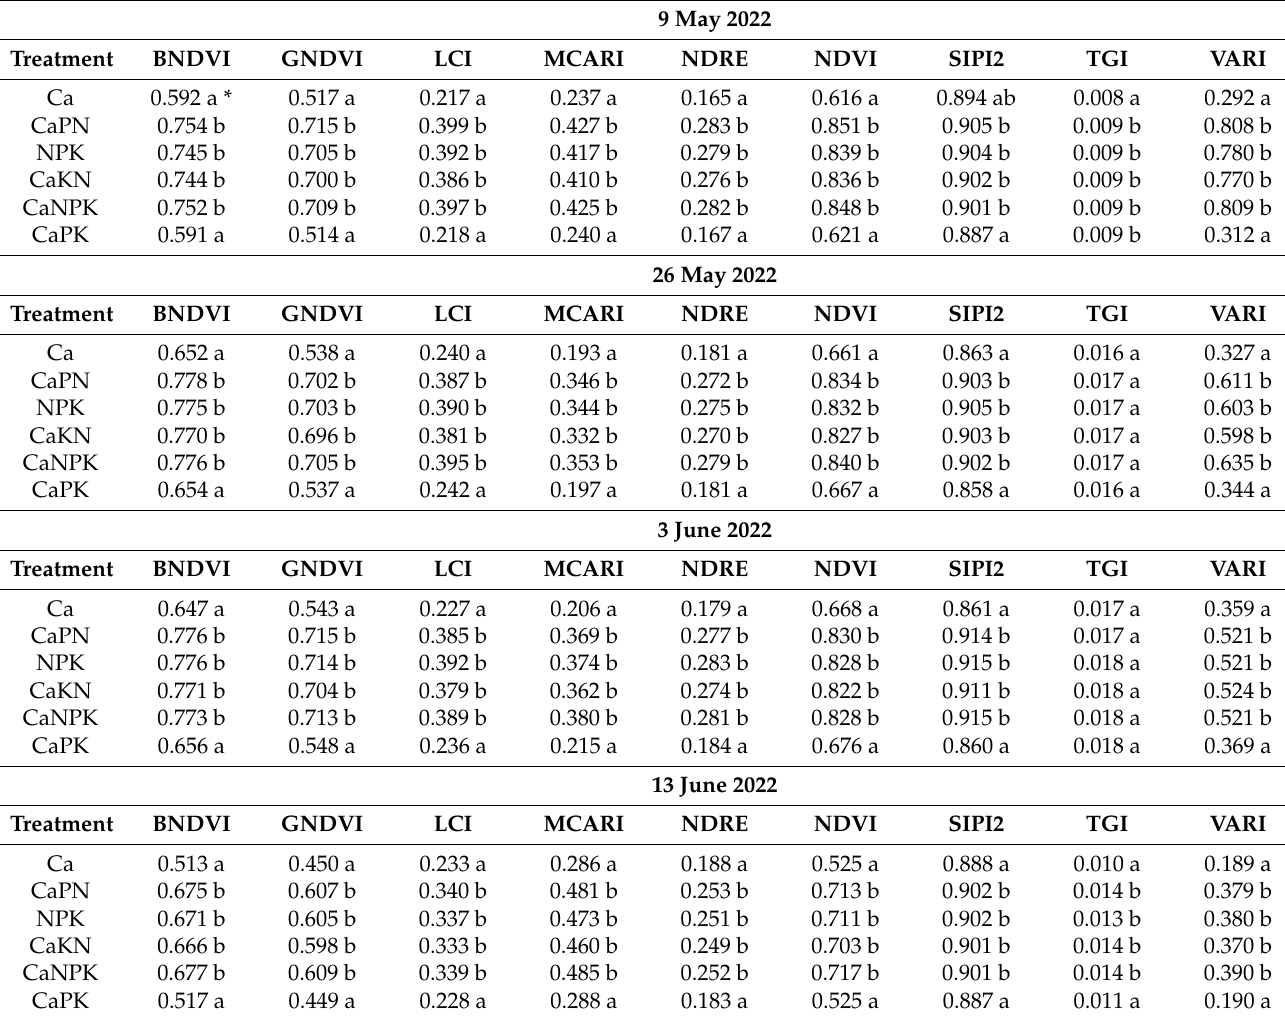
Table 6. Means of vegetation indices in field experiment 3 (with manure application and crop rotation) and comparisons of means based on Tukey’s